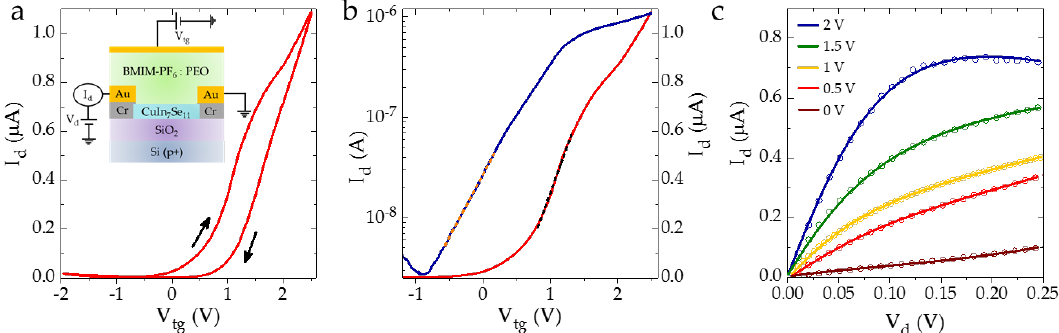
Figure 3. Electronic transport of the CuIn 7 Se 11 FET with the ion-gel gate (Device III): ( a ) Transfer characteristics for forward cycle and reverse cycle using the ion-gel top gate, inset: schematic of the EDL-FET; ( b ) Transfer characteristics with ion-gel gate for forward cycle in the linear scale (red) and semi-log scale (blue); and ( c ) output characteristics under different top gate voltages (0 V ≤ V tg ≤ +2 V) are shown.